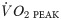
A) Six-minute walking distance (6MWD) and B) oxygen consumption at the peak of cardiopulmonary exercise test (V˙O2PEAK) as a function of maximum inspiratory pressure (MIP). Horizontal gray lines represent median of variables.